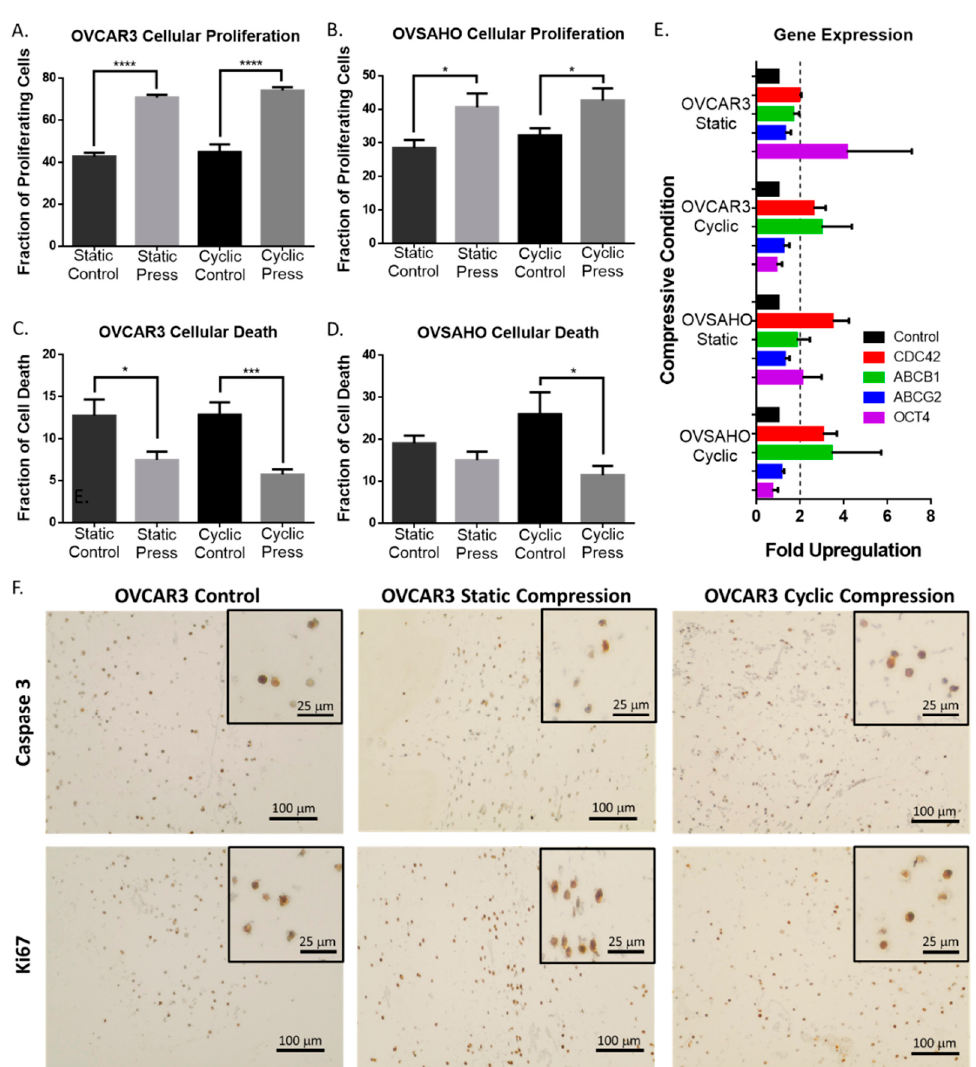
Figure 3. Compressive stimulation of ovarian cancer cells causes significant changes in proliferation, cell death, and gene regulation. Cellular proliferation of ( A ) OVCAR3 and ( B ) OVSAHO cells under static and cyclic compressive stress stimulation for 24 h (IHC ki67 expression). Cell death of ( C ) OVCAR3 and ( D ) OVSAHO cells under static and cyclic compressive stress stimulation for 24 h (IHC cleaved caspase 3 expression). (Significance calculated via t -test; n ≥ 3 experimental replicates, **** p < 0.0001, *** p < 0.001, ** p < 0.01, * p < 0.1). ( E ) Gene expression changes via RT-qPCR for ovarian cancer cells stimulated for 24 h under static or cyclic compressive conditions. A two-fold upregulation is indicated by the dotted line. ( F ) Representative IHC images of OVCAR3 expression of cleaved caspase 3 and ki67 under compressive stress stimulation for 24 h.